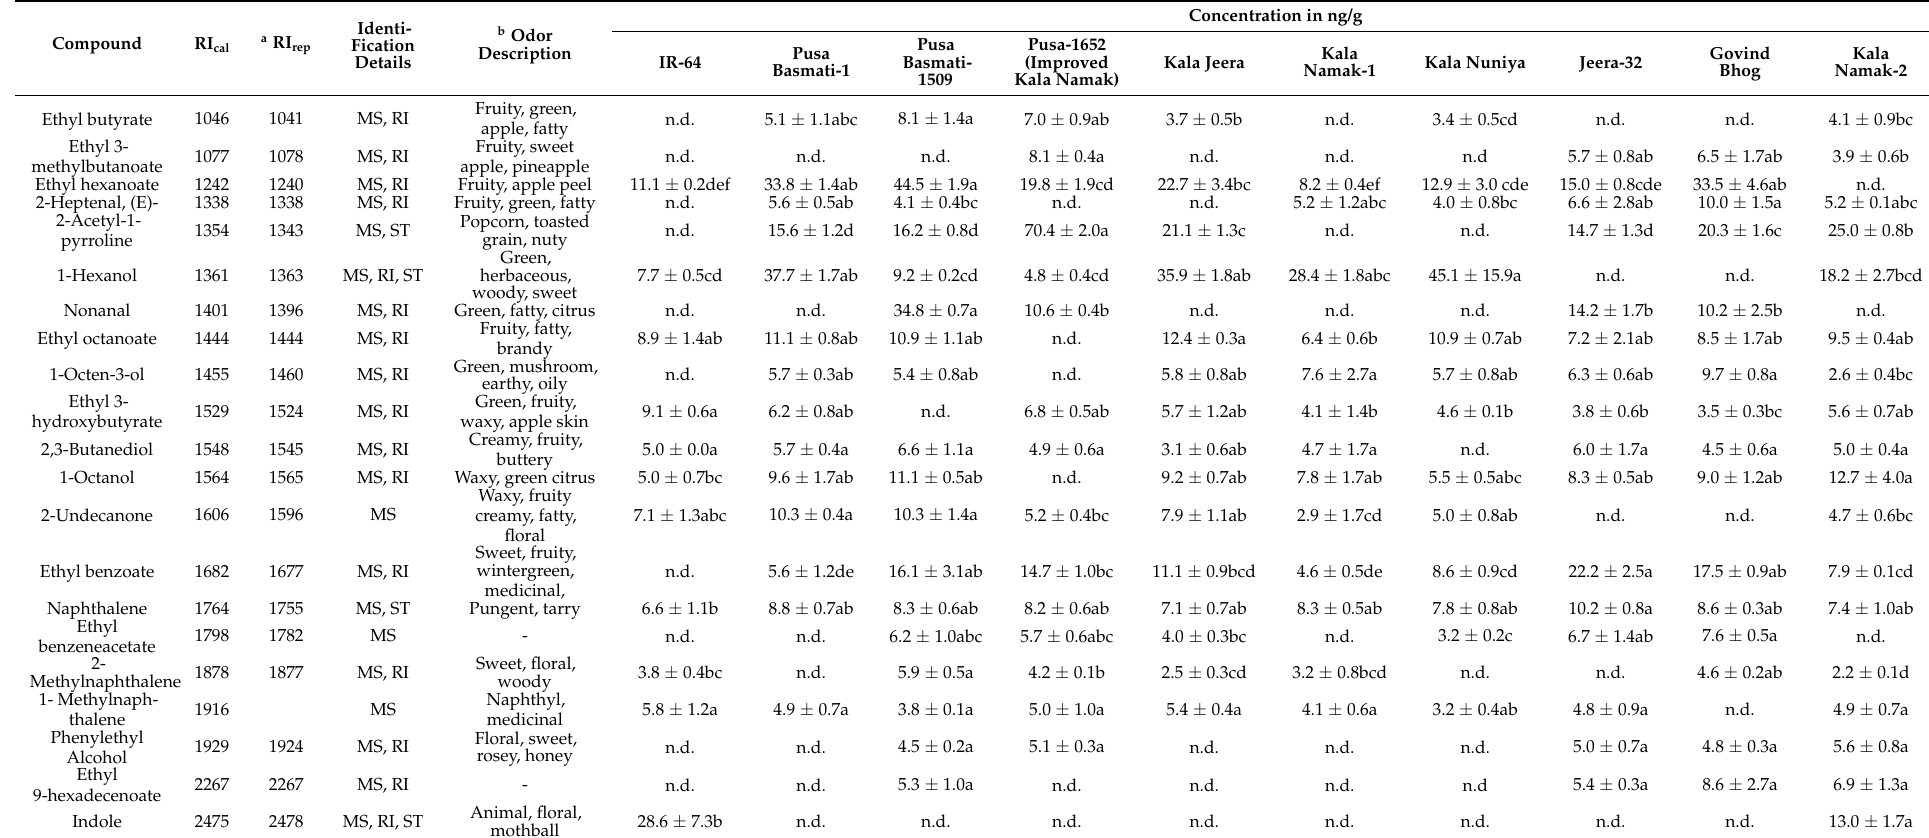
Table 2. Identified major volatile compounds and their relative levels in cooked rice samples of ten traditional and improved